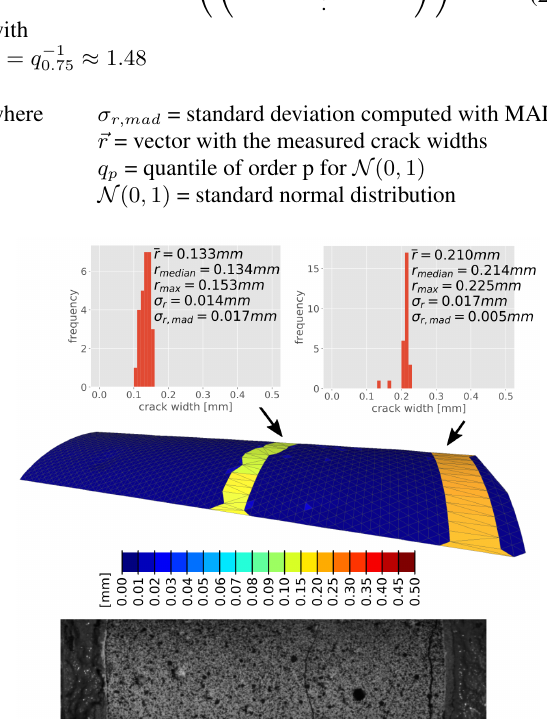
Figure 12. Color-coded visualization of || (cid:126)t rel, 2 D || for epoch 25 at 0.24 ms. For the two cracks, histograms of the crack widths are depicted. In addition, the original image of one camera is